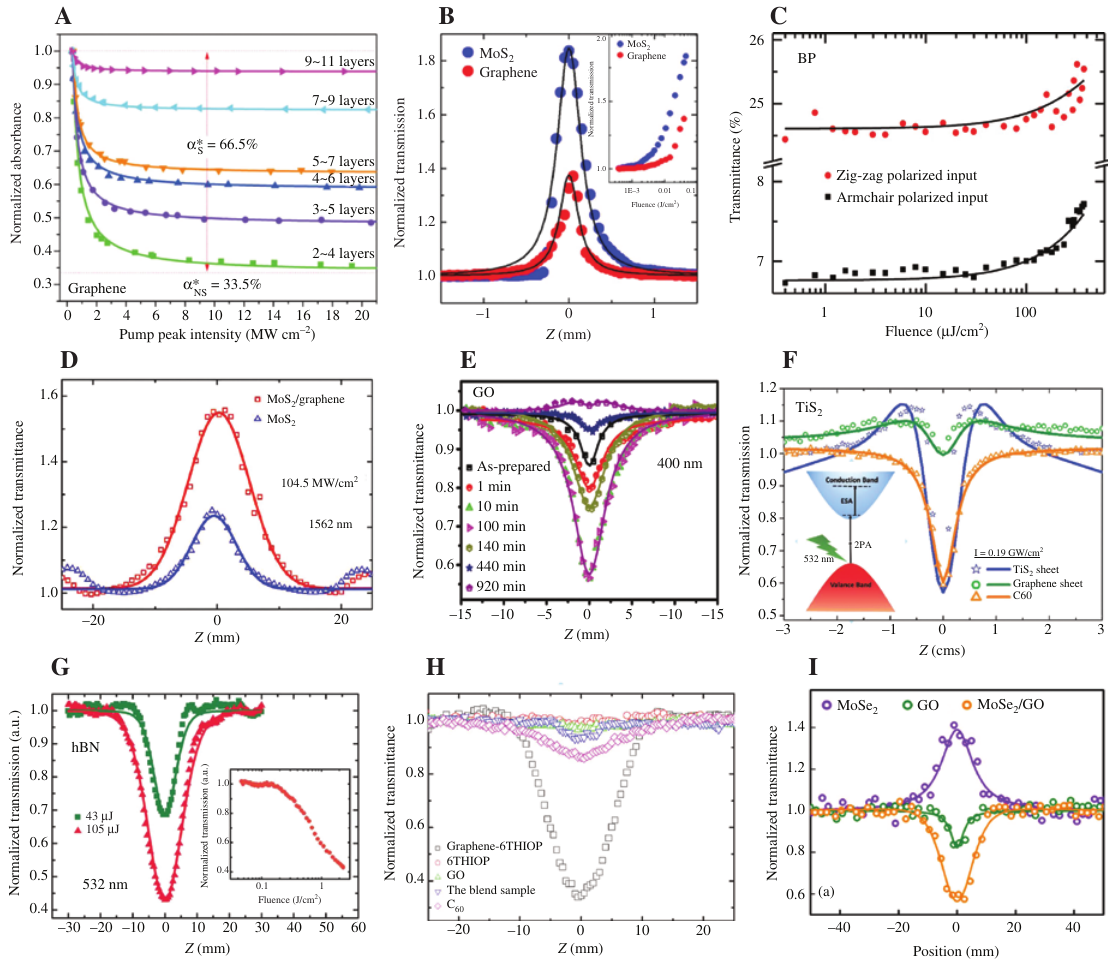
Figure 10: Nonlinear absorption in 2DLMs. (A) Nonlinear absorption of graphene films with different numbers of layers. Reproduced from Ref. [111]. Copyright 2009 John Wiley and Sons. (B) Z -scan results show saturable absorption of MoS ( T = 34.4%) and graphene ( T = 16.5%). (Inset) Normalized transmission as a 2 function of fluence. Reprinted (adapted) with permission from Ref. [94]. Copyright 2013 American Chemical Society. (C) Fluence